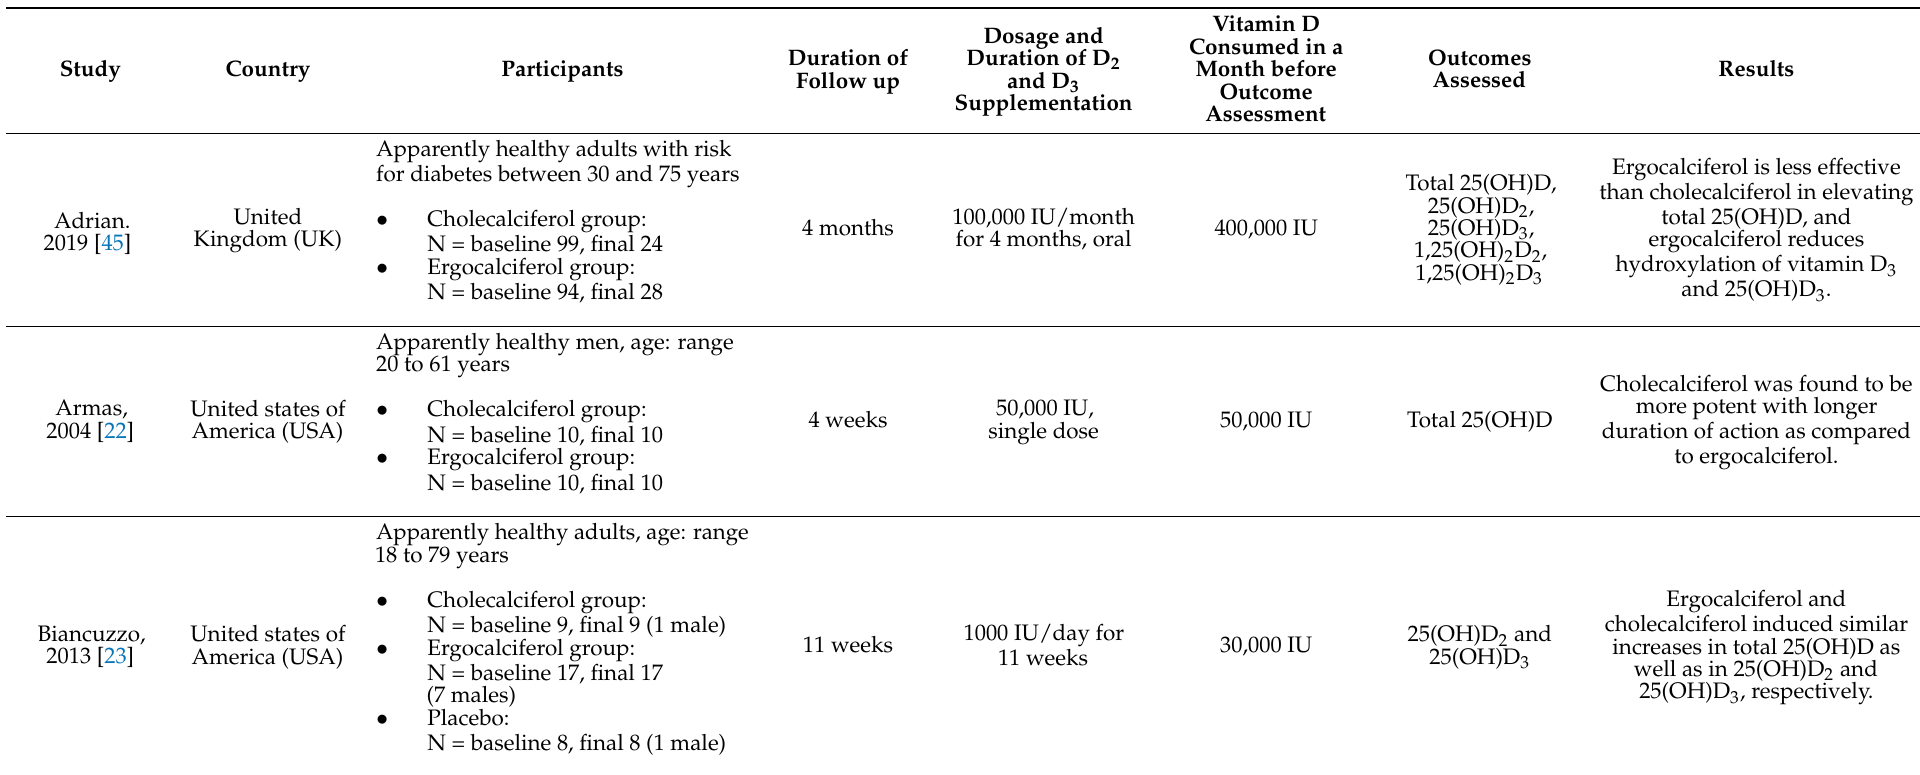
Table 1. Description of